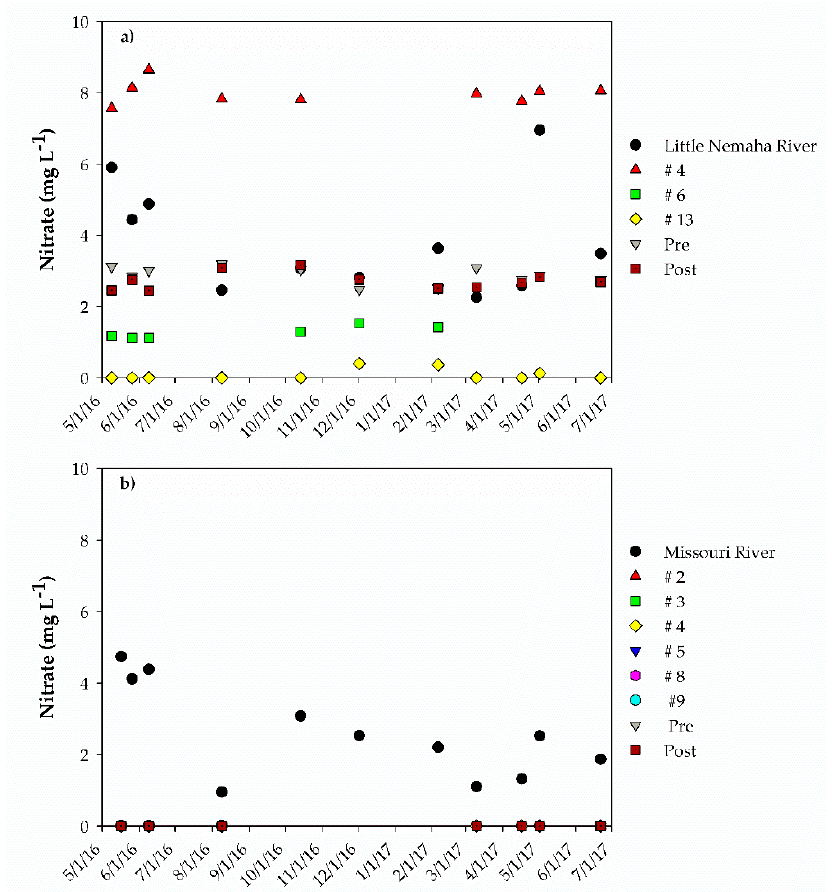
Figure 1. Nitrate (in NO 3 –N) in ( a ) Auburn and ( b ) Nebraska City. LNR: Little Nemaha River;